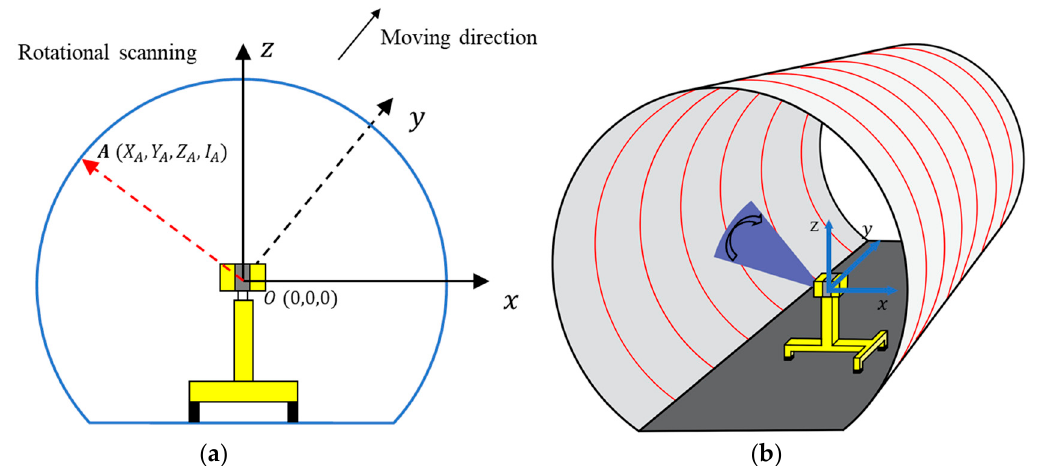
Figure 2. Schematic illustration of the mobile laser scanning (MLS) system (GRP5000).